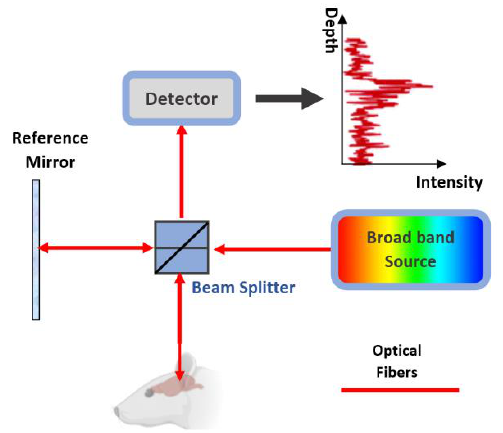
Figure 4. Basic optical coherence tomography (OCT) setup based on Michelson interferometer.